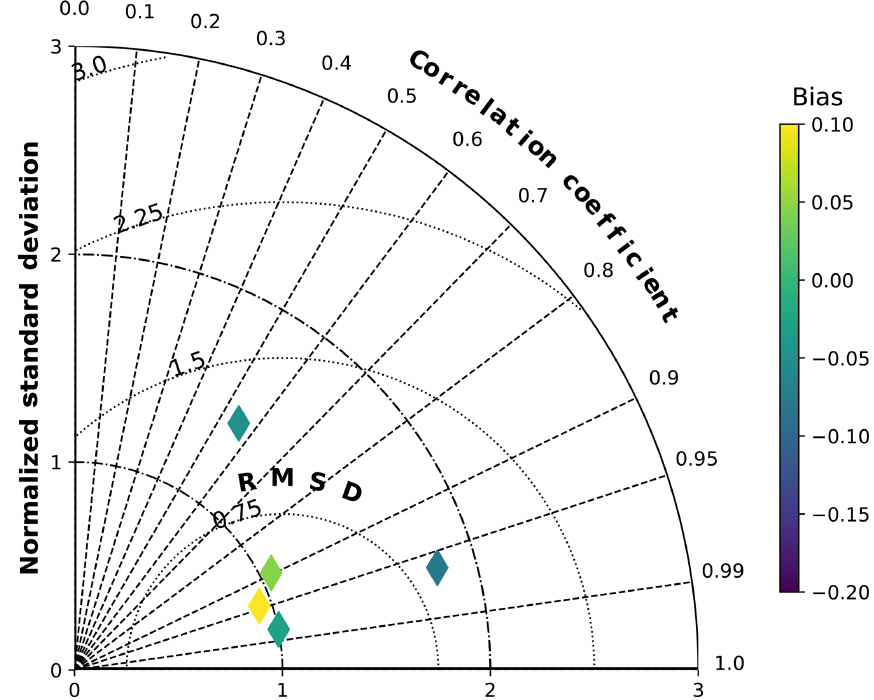
Figure A8. Taylor diagram showing agreement between pairwise-located FP